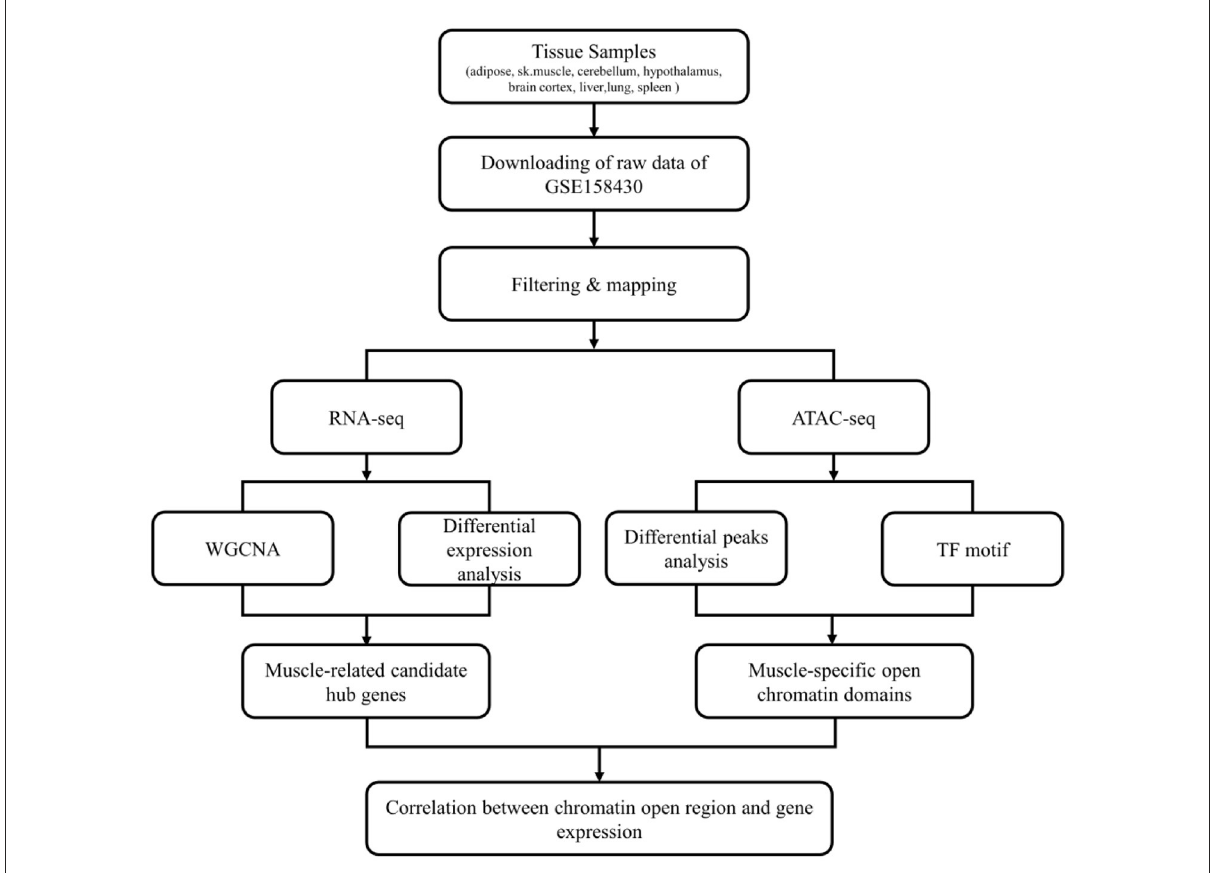
FIGURE1 The flow chart of whole